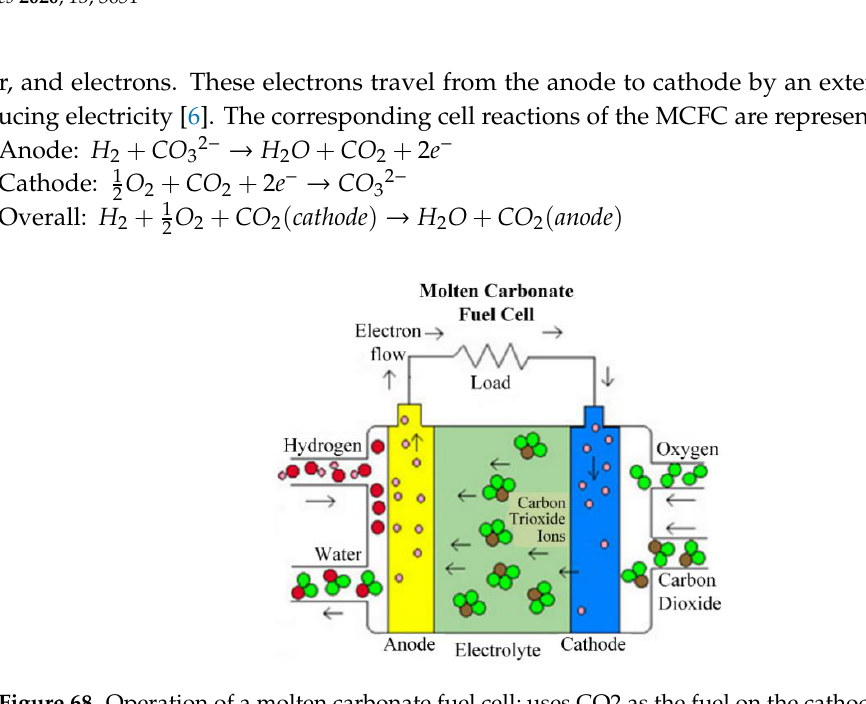
Figure 68. Operation of a molten carbonate fuel cell; uses CO2 as the fuel on the cathode side, while hydrogen is extracted from hydrocarbon fuel and supplied on the anode side. Molten lithium sodium carbonate or lithium potassium carbonate salts are used as the electrolyte [105].